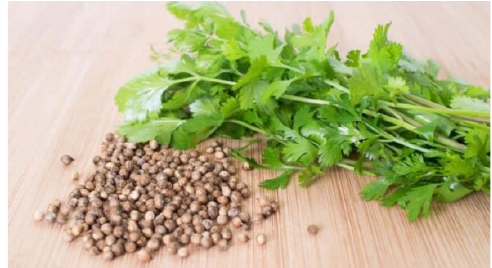
Figure 2. Coriandrum sativum plant and seeds.